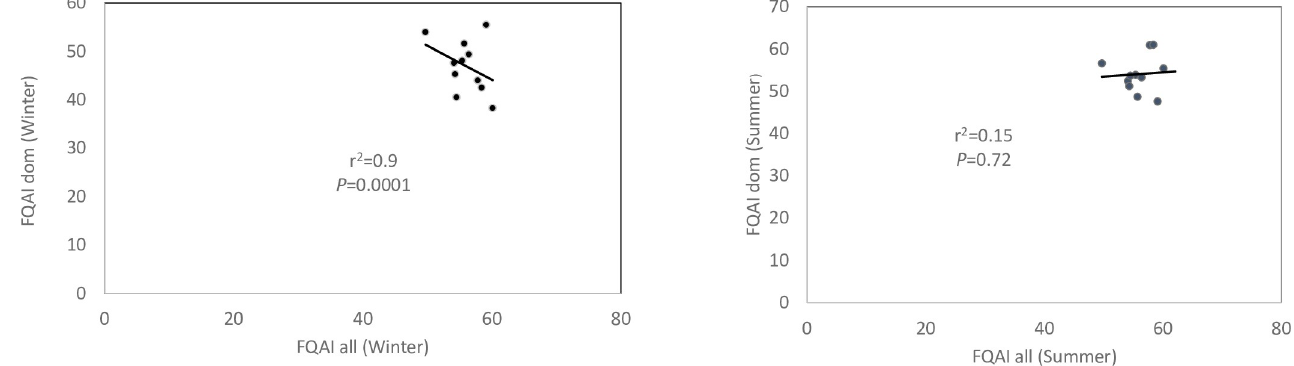
Fig 7. Regression analysis of FQAIall (all species) and FQAIdom (dominant species) for summer and winter.